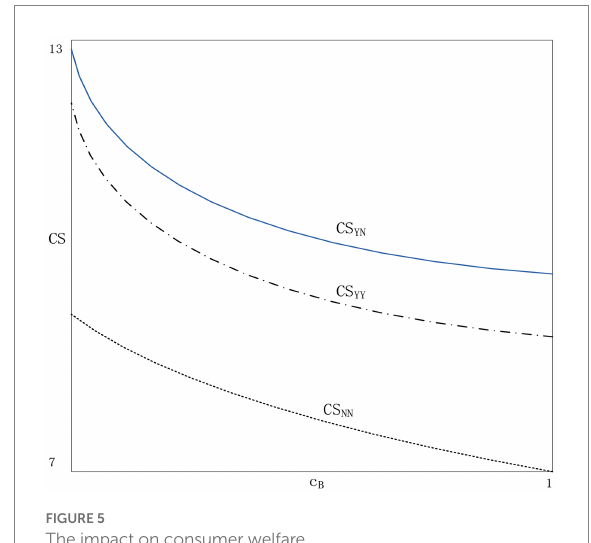
The impact on consumer